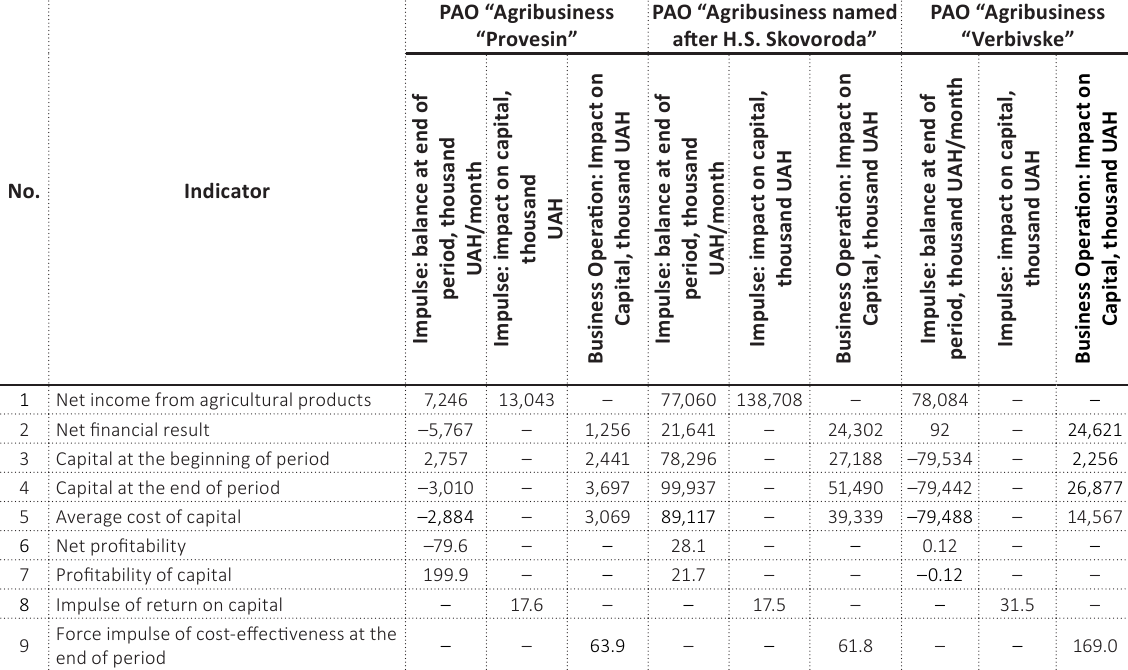
Source: Developed by the authors based on SMIDA (2020).